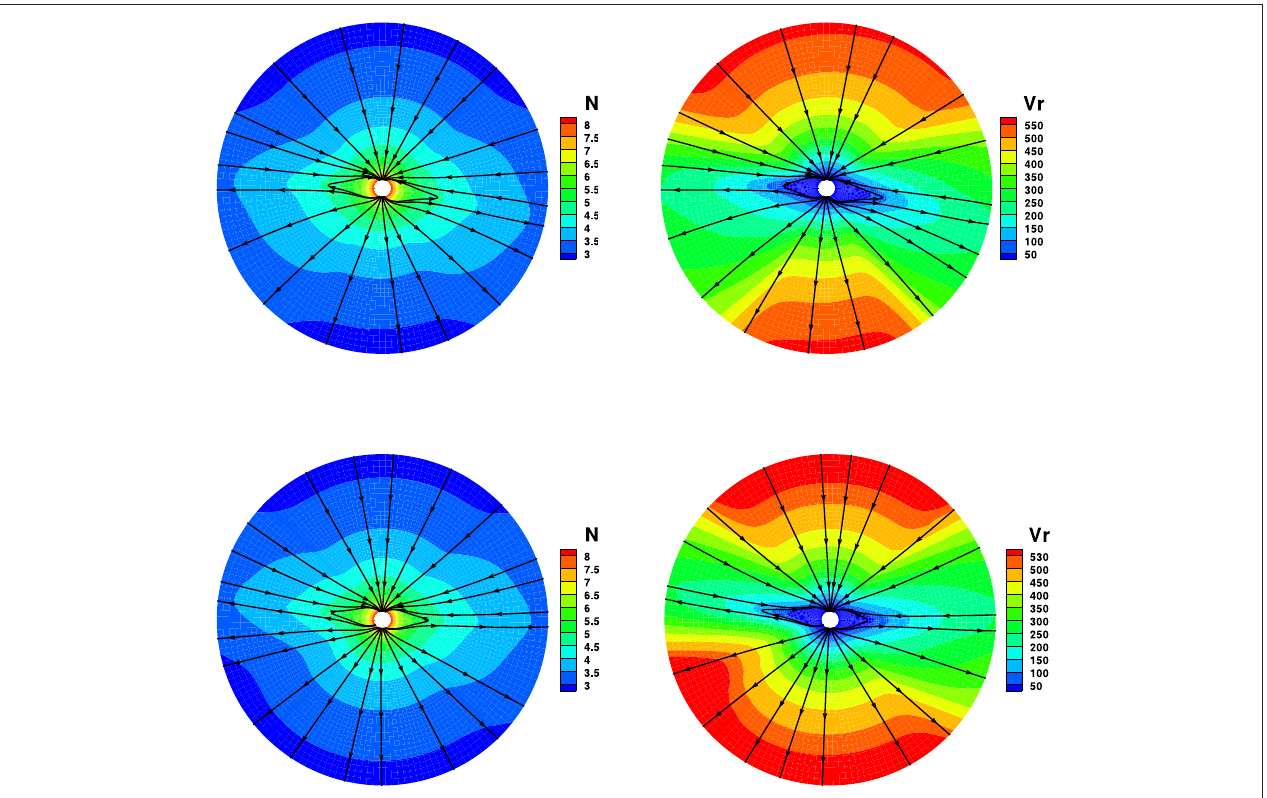
FIGURE 3 | The model results with diffusive divergence cleaning method, the magnetic field lines, radial speed v r (km/s), and number density N ( log 10 / cm 3 ) on the meridional plane of φ = 180 ◦ − 0 ◦ (top) and φ = 270 ◦ − 90 ◦ (bottom) from 1 to 20 R s .